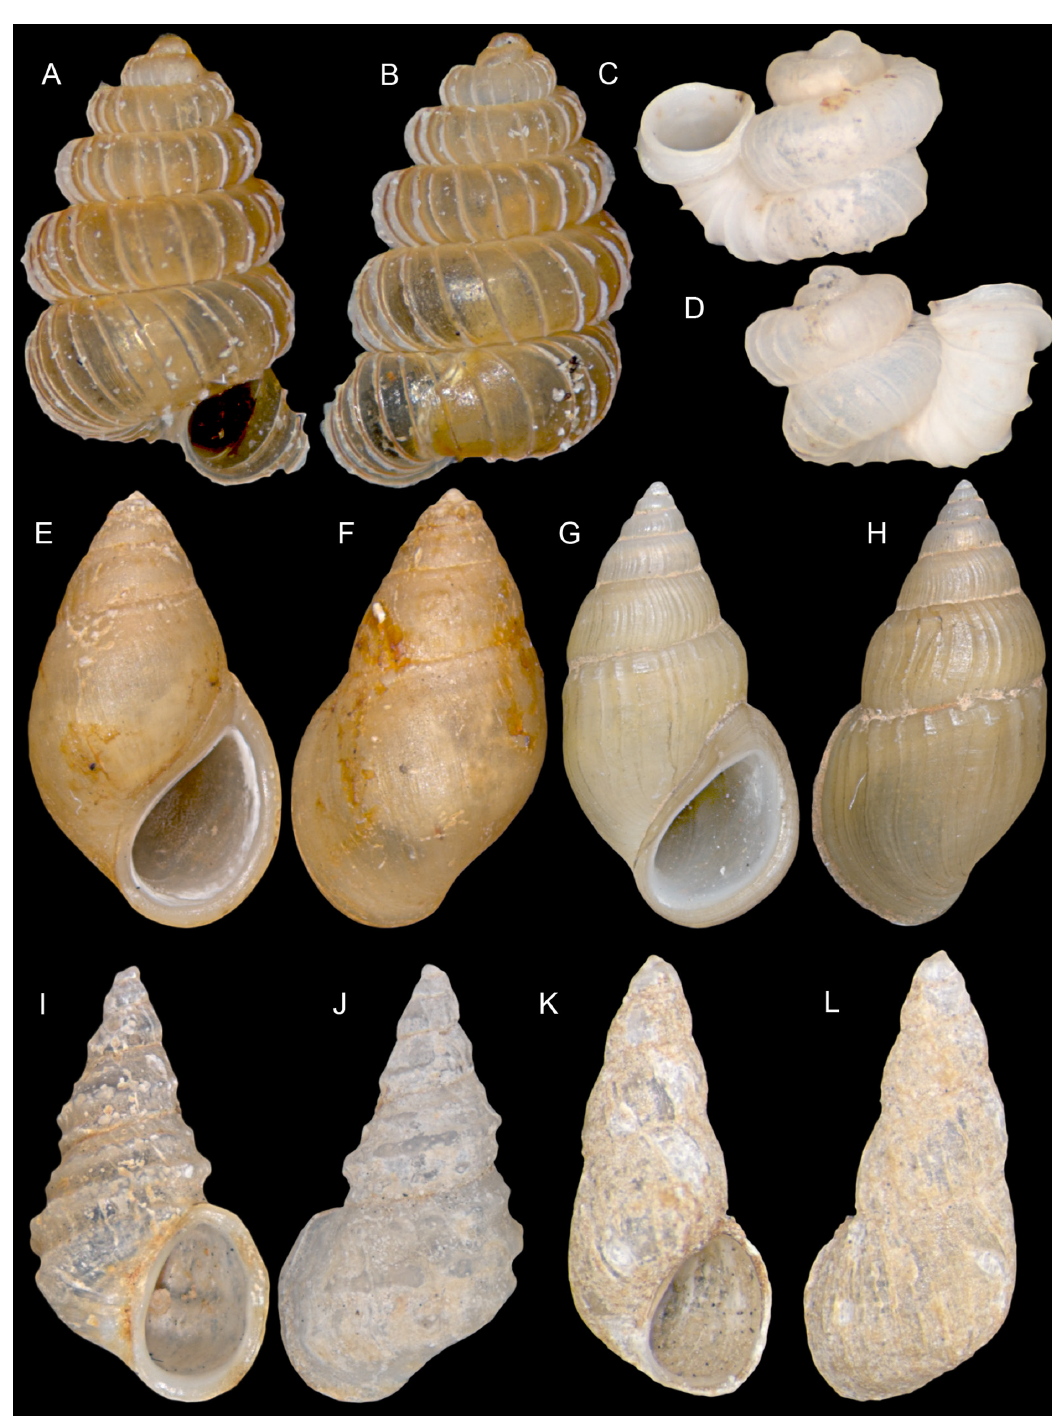
Fig. 2. A–B . Opisthostoma christae Maassen, 2001, paratype MZSP 95472, L = 2.55 mm, W = 1.55 mm. C–D . Opisthostoma secretum Maassen, 2002, probable paratype MZSP 95917, L = 0.9 mm, W = 1.28 mm. E–F . Pachydrobia bavayi Brandt, 1970, probable paratype MZSP 95911, L = 6.8 mm, W = 4 mm. G–H . Pachydrobia crooki Brandt, 1968, probable paratype MZSP 95469, L = 12.8 mm, W = 6.8 mm. I–J . Paraprososthenia brandti Temcharoen, 1971, probable paratype MZSP 95946, L = 5.25 mm, W = 3 mm. K–L . Paraprososthenia fischerpiettei Brandt, 1970, probable paratype MZSP 95496, L = 4.72 mm, W = 2.2